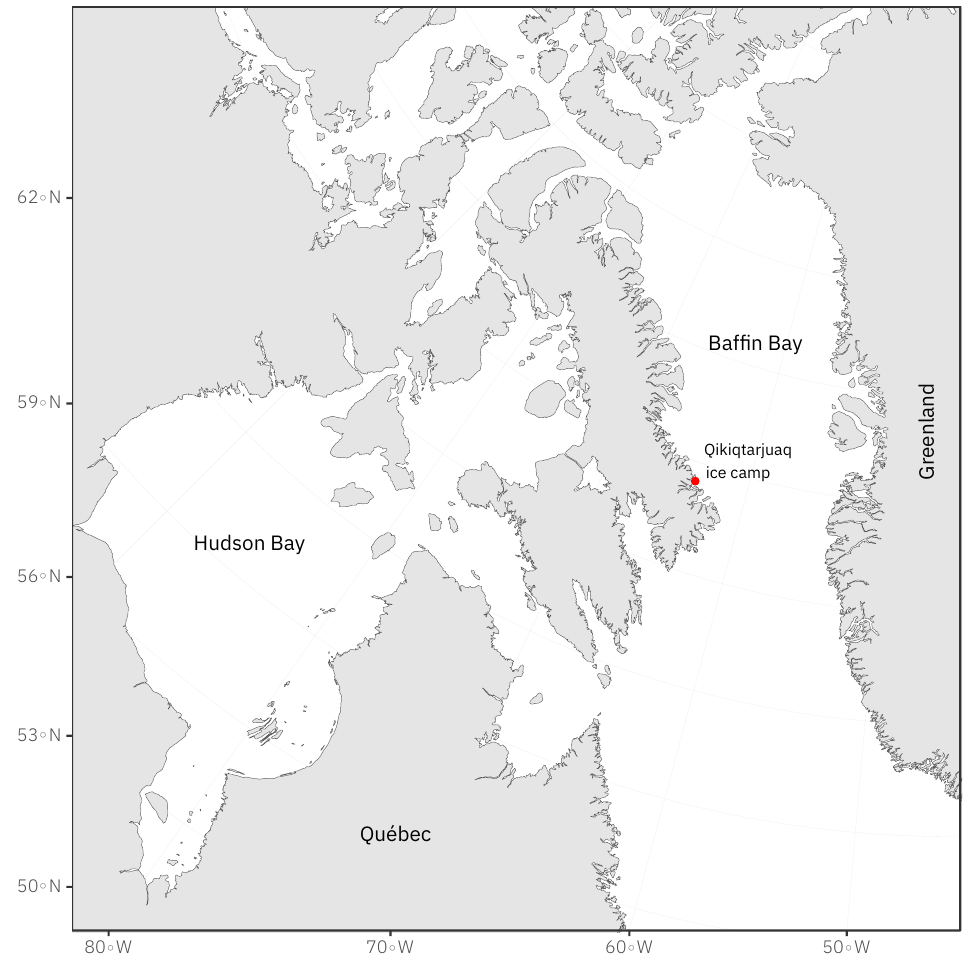
Figure A1. The field campaign was part of the GreenEdge project (www.greenedgeproject.info) which was conducted on landfast ice southeast of the Qikiqtarjuaq Island in the Baffin Bay (67.4797N, 63.7895W).